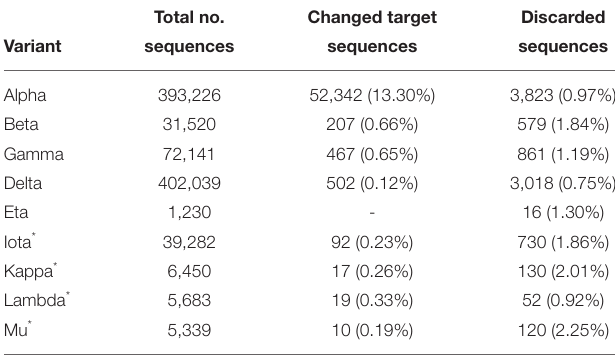
TABLE 1 | Analysis of sequences downloaded from GISAID on 2021-09-06. Total